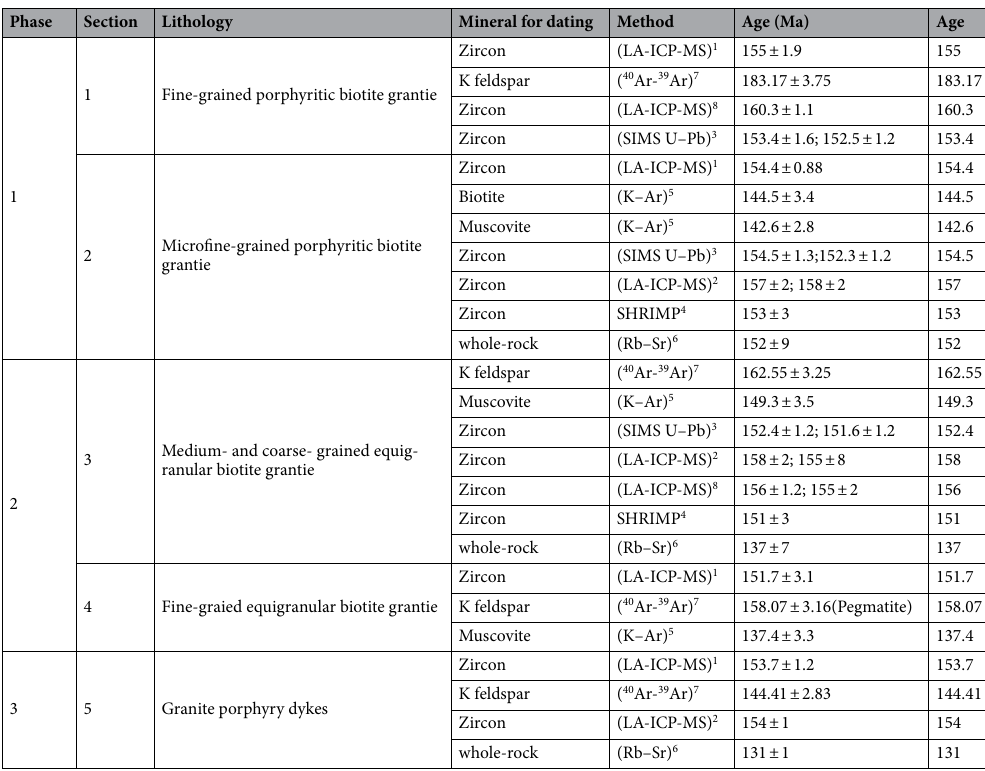
Table 5. Ages of the QGC from this study and the literature. Reference: 1. This study; 2. Chen et al. (2016) 14 ; 3. Guo et al.(2015) 27 ; 4. Li et al. (2004) 28 ; 5. Yin et al. (2002) 29 ; 6. Mao et al. (1998) 26 ; 7. Liu et al. (1997) 25 ; 8. Chen et al. (2014) 13 .